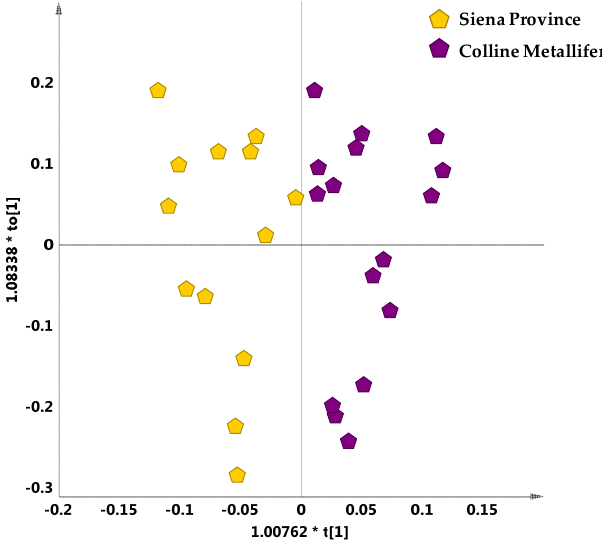
Figure 7. OPLS-DA (1 + 1 + 0 components give R 2 X = 0.74, R 2 Y = 0.75, Q 2 = 0.65) scores plot for samples from two main referenced geographical areas and exclusively present in the scattered macro group.